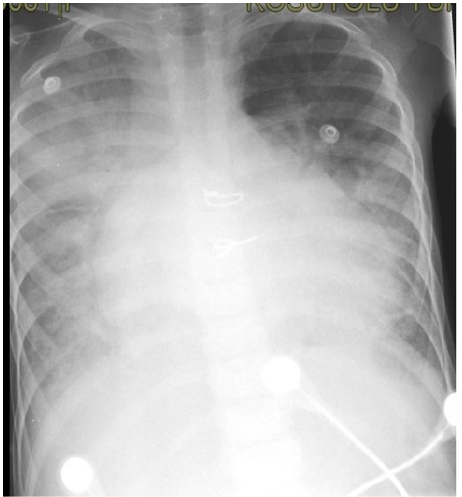
Fig. 2 - Tele-imaging of the case with dilated cardiomyopathy who is positive for coronavirus disease